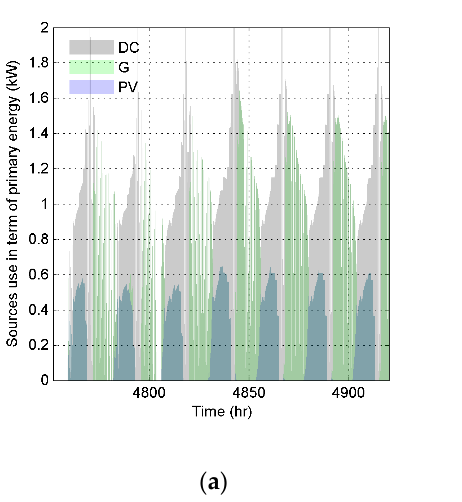
Figure 17. Comparison between actual indoor air temperature ( 𝑇 air ) and its prediction in the MPC with OF P and PH of 18 h.